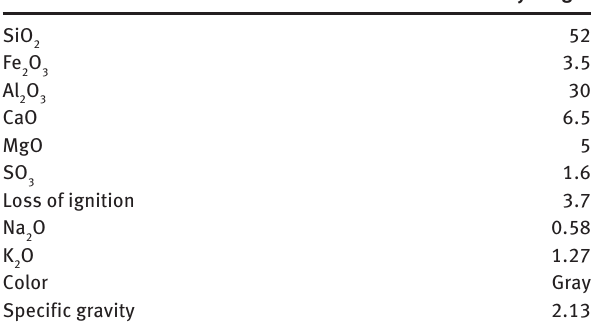
Table 3 Chemical and physical properties fly